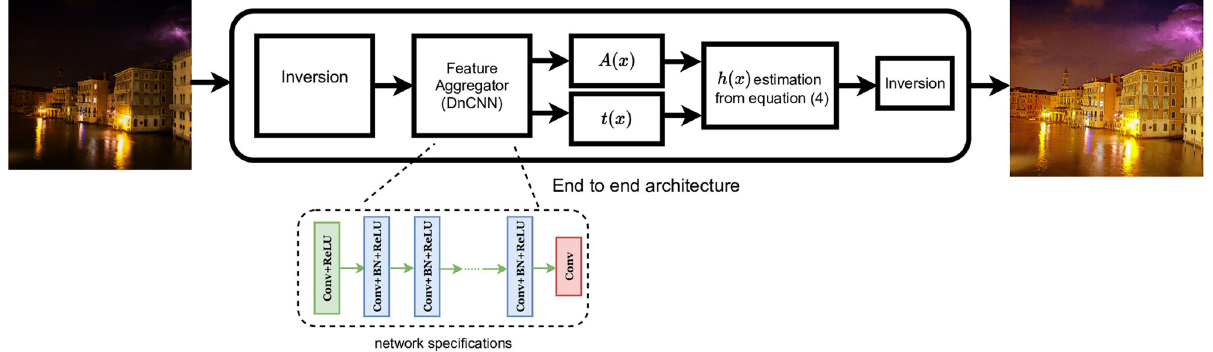
Fig 2. Schematic network of the proposed study. We perform image inversion in the beginning and end to simulate hazy image. We use DnCNN [39] as the feature aggregator, which internal architectural details are provided here. The network approximates the atmospheric components of Eq (4) with semi-supervised training and the reformulated hazy Eq (3) is solved before the